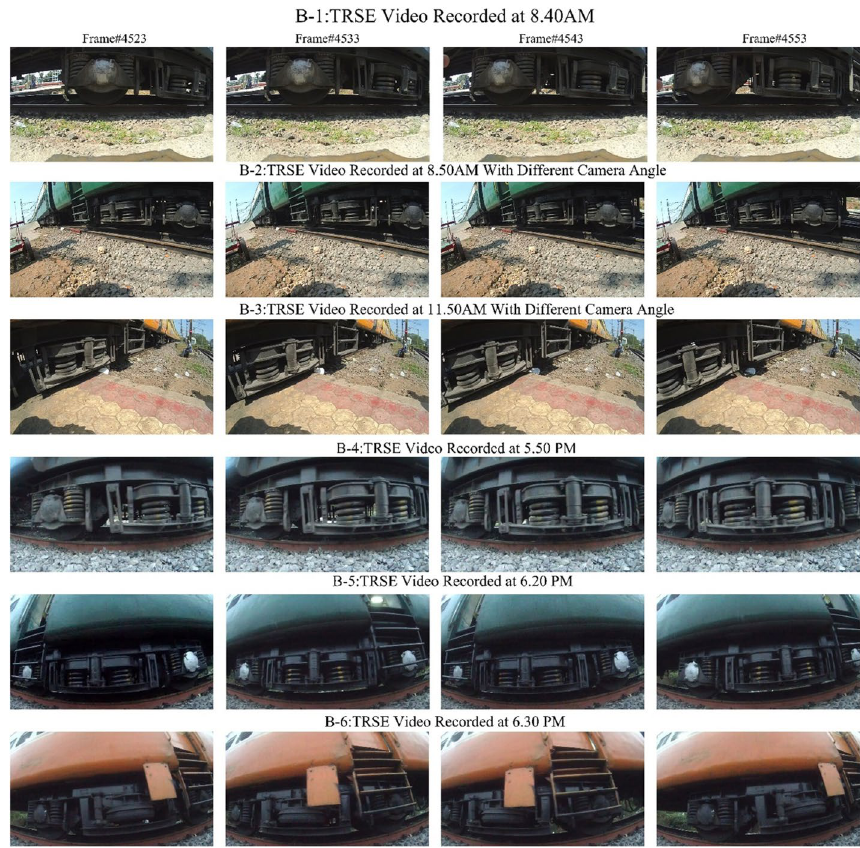
Fig. 5 Datasets for TRSE used for experimentation